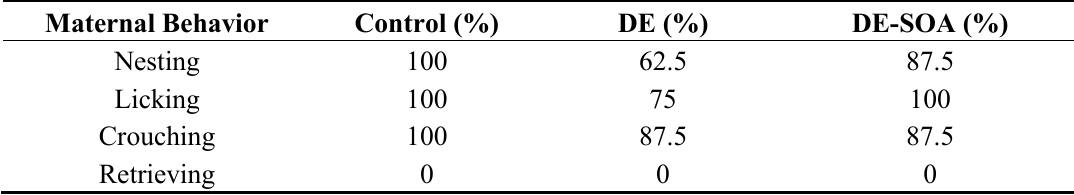
Table 3. Percentage of mice showing maternal behavior at PND 12.